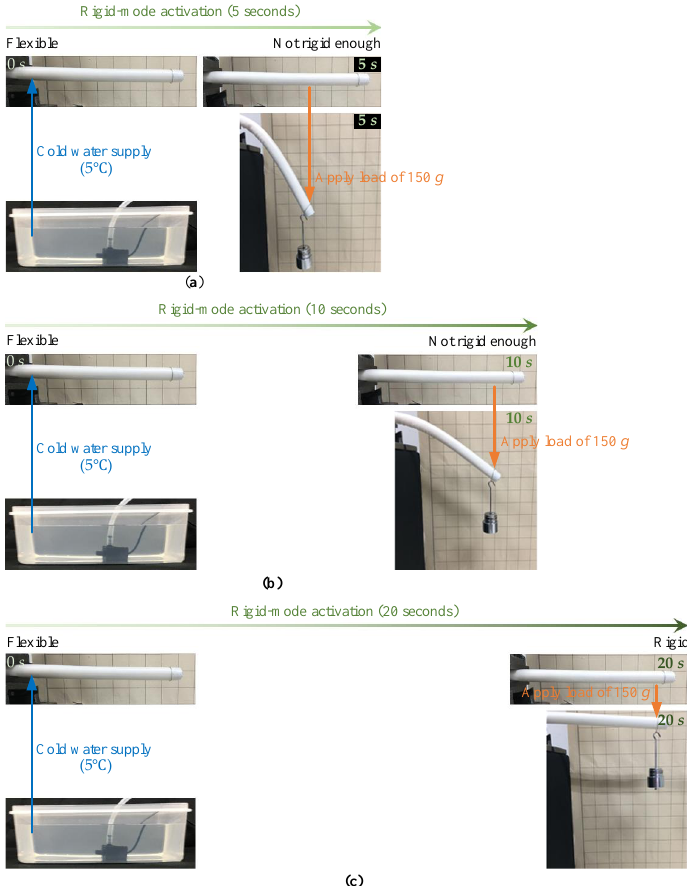
Figure 6. Rigid mode activation (from flexible mode to rigid mode) with cold water (5 ◦ C) supply: ( a ) conducting rigid mode activation in manipulator in flexible mode for 5 s, which led to the manipulator not being rigid enough; ( b ) conducting rigid mode activation in manipulator in flexible mode for 10 s, which led to the manipulator not being rigid enough; ( c ) conducting rigid mode activation in manipulator in flexible mode for 20 s, the manipulator showed the desired